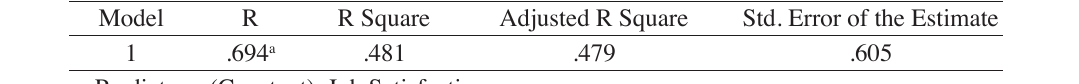
Table 9: Impact of Job Satisfaction on Intention To Leave Model R R Square Adjusted R